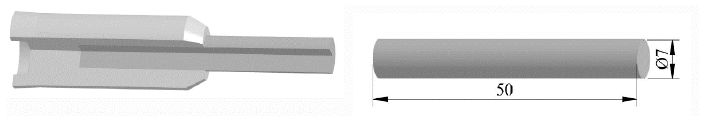
Figure 4. Assembly drawing of the long rod projectiles (LRPs) and sabot (Unit: mm).